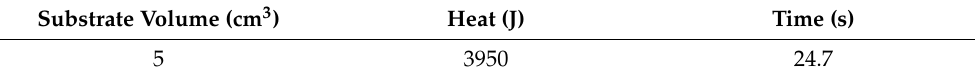
Table 1. Summary of the conditions to produce a temperature increase of 300 ◦